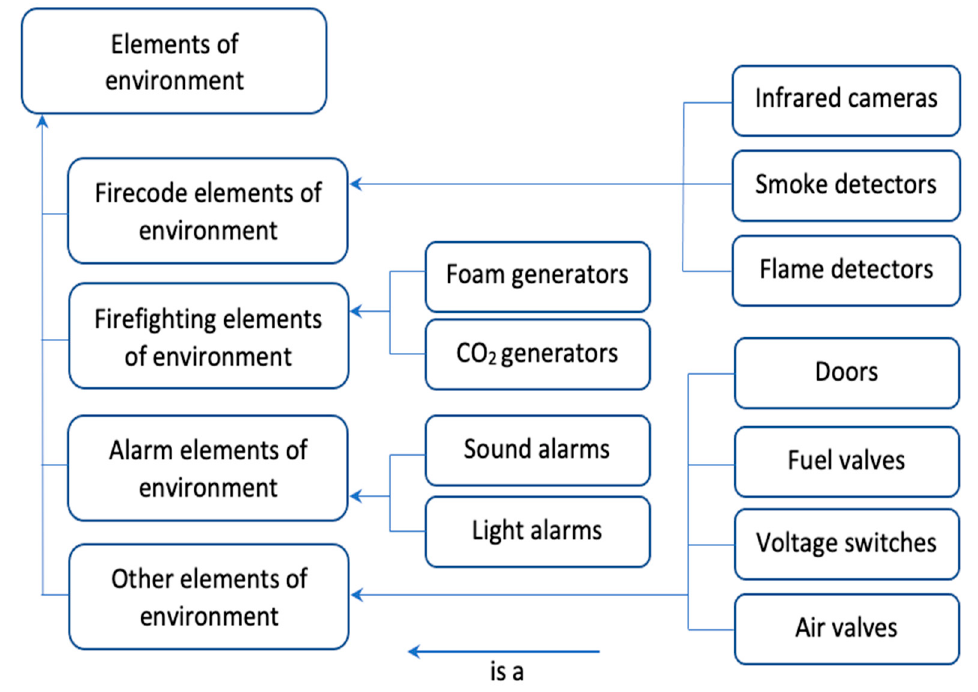
Figure 1. Part of the semantic network of model categories.